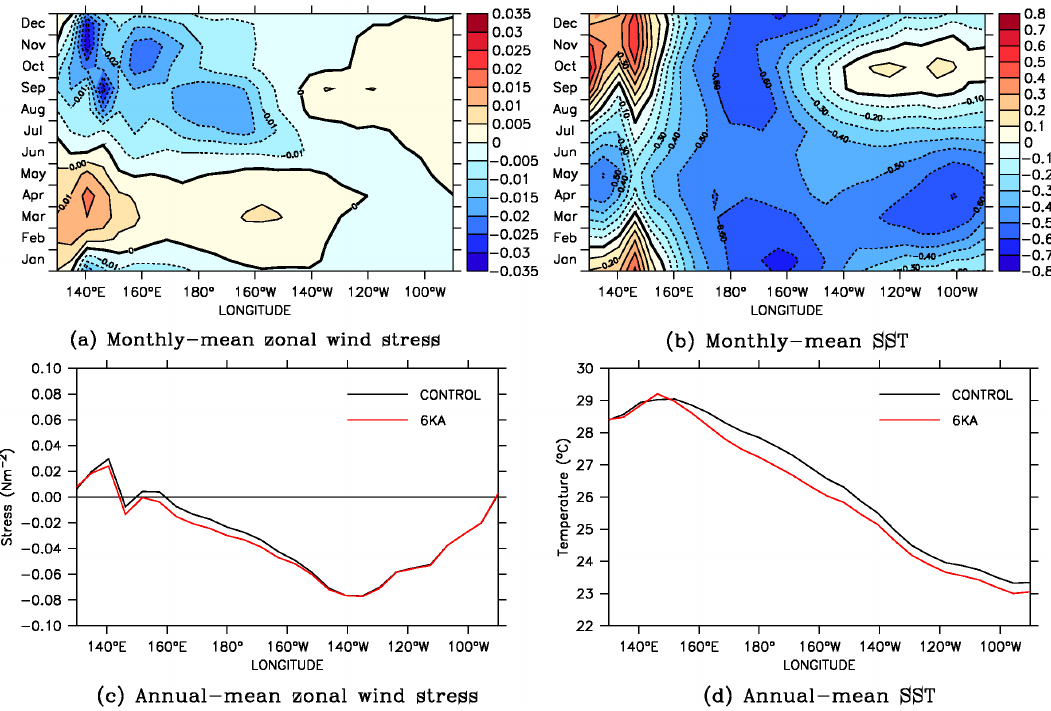
Fig. 5. The equatorial zonal wind stress (Nm − 2 ) and sea surface temperature (SST, ◦ C) for years 201–1200 of experiment 6KA: (a) monthly- mean zonal wind stress, expressed as anomalies relative to CONTROL, (b) monthly-mean sea surface temperature, expressed as anomalies relative to CONTROL, (c) annual-mean zonal wind stress, and (d) annual-mean sea surface temperature. The values shown are averages over the region 5 ◦ S–5 ◦ N.